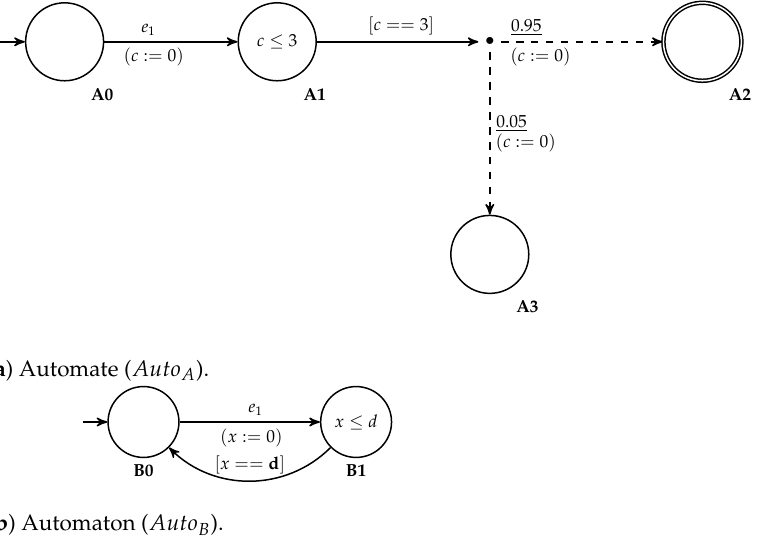
Figure 4. Example of a stochastic timed